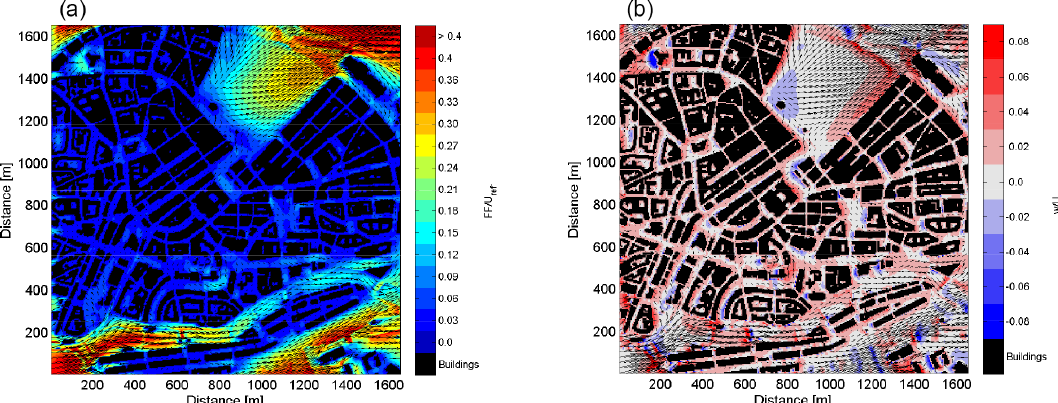
Figure 5. Wind field at pedestrian height level in the city center of Hamburg (Germany) showing the normalized wind speed (a) and the vertical wind (b) . Black arrows qualitatively show the wind circulation. The simulated domain size is approximately 2000m × 2000m and the x and y axes are aligned to the west–east and north–south directions, respectively. The simulated mean wind direction is southwest and the atmospheric stratification is neutral. A grid spacing of 5m in all spatial directions is used. All input data are taken from the digital terrain model, the data of the Germangeo information system ATKIS (Official Topographic–Cartographic Information System), and the 3-D urban model data (LoD2) for building details.